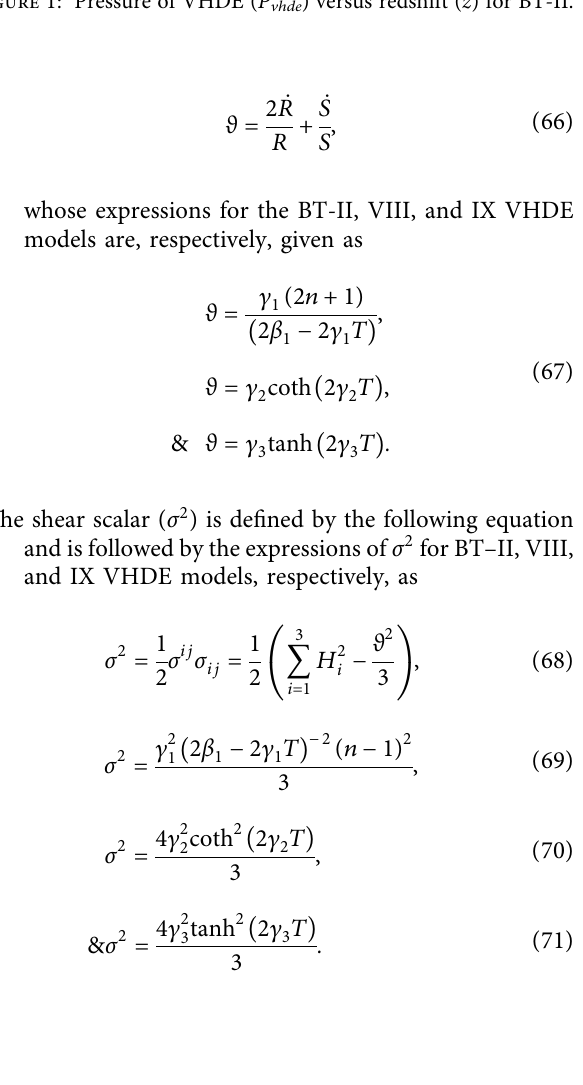
Figure 1: Pressure of VHDE ( P vhde ) versus redshift ( z ) for